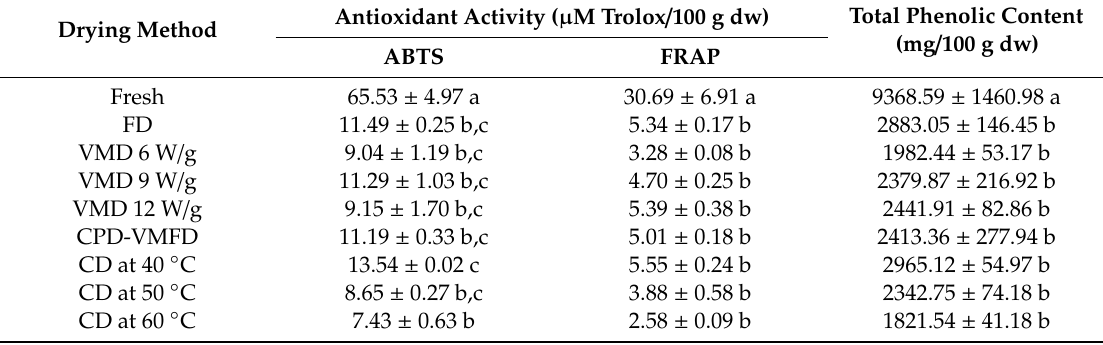
Table 3. Antioxidant activity and TPC of C. alata, influenced by various drying methods and conditions. Drying